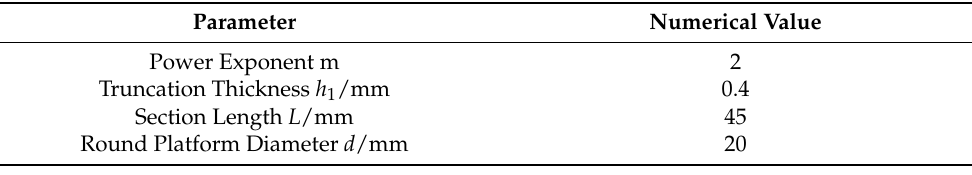
Table 2. ABH geometric parameters.